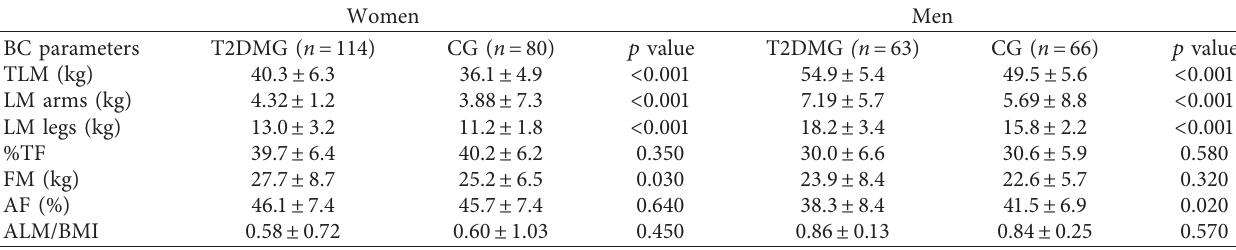
Table 2: Body composition (BC) stratified by sex.